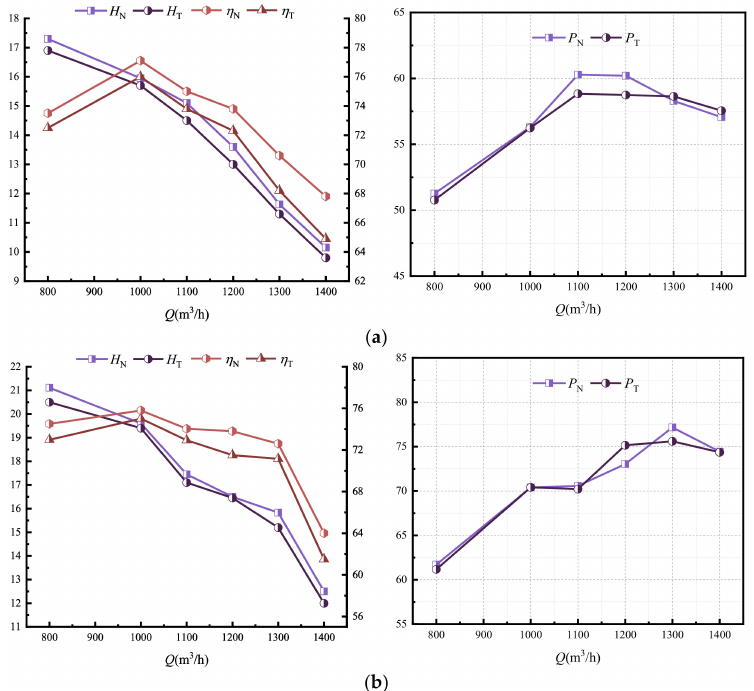
Figure 6. Comparison of performance between CFD prediction and experiment: ( a ) three-blade; ( b ) six-blade. Note: H , η and P represent head (m), efficiency (%) and power (kw), respectively. Subscripts N and T represent numerical calculated value and test value,